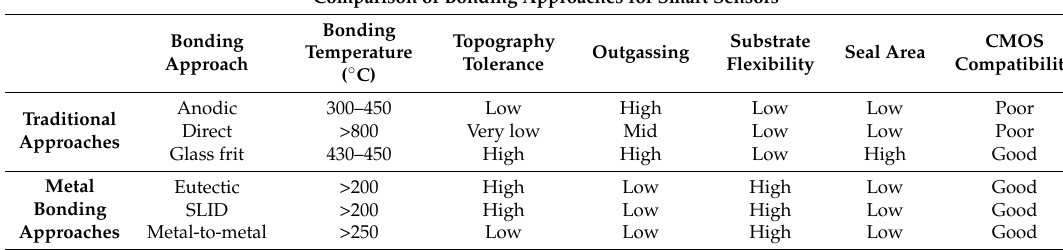
Table 1. Comparison of traditional wafer bonding approaches used for discrete microelectromechanical systems (MEMS) with metal bonding approaches more suitable for wafer-level vacuum packaging (WLVP) of smart sensors.